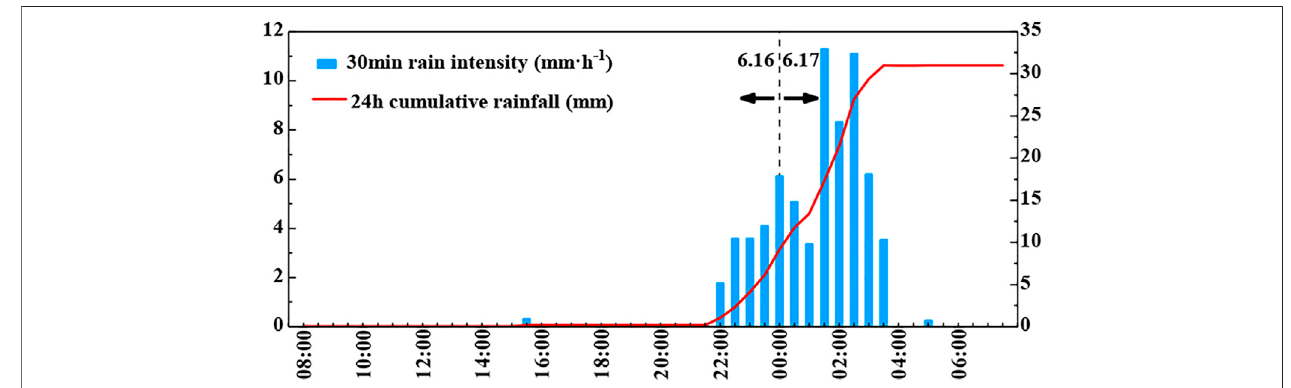
FIGURE 3 | Curve of rainfall at Banshanmen town, Danba County, on June 16 and 17,